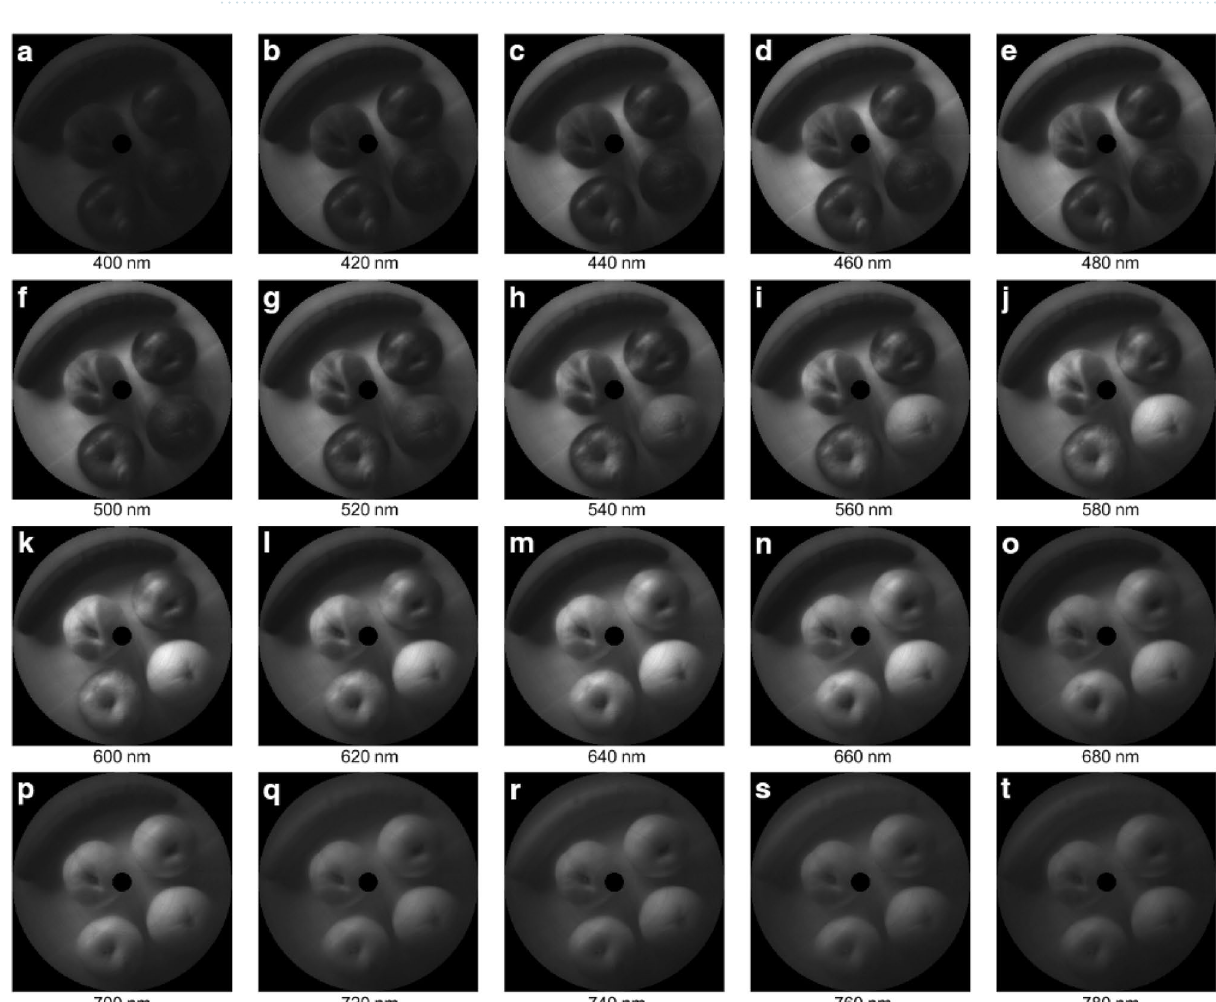
Figure 8. spectral image at different wavelength